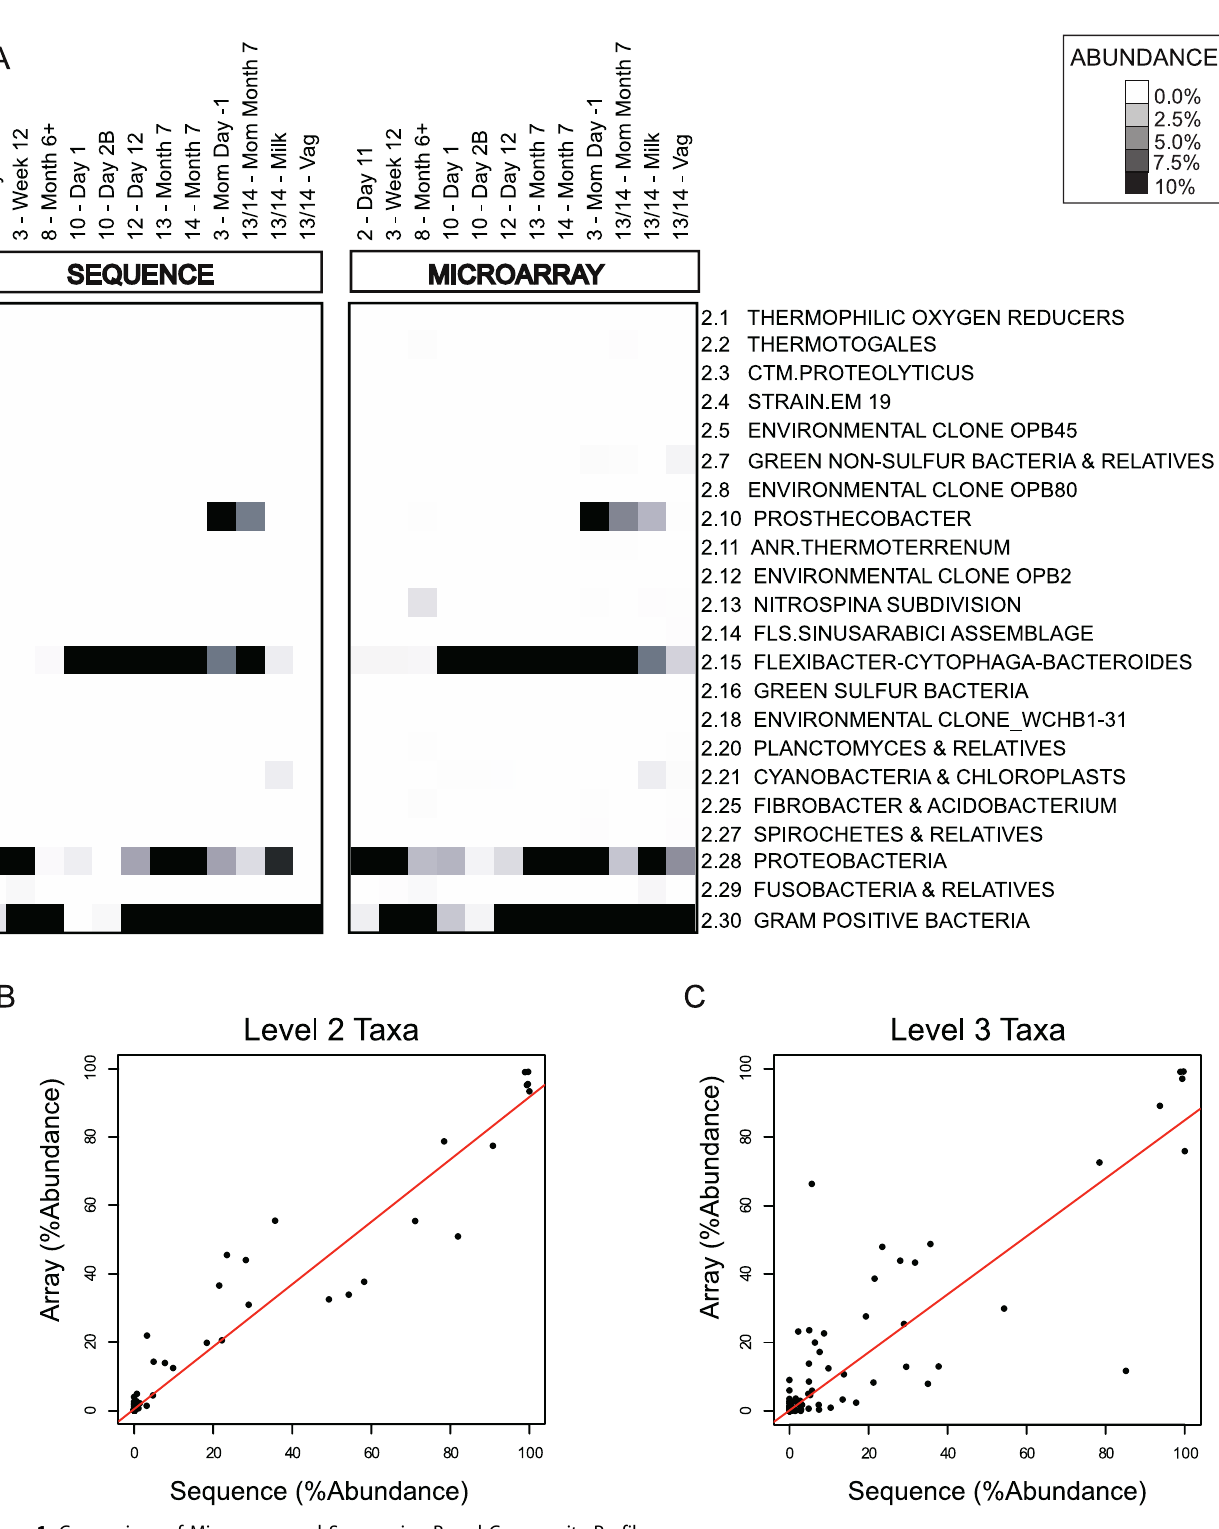
Figure 1. Comparison of Microarray- and Sequencing-Based Community Profiles Microarray-derived and sequencing-derived data estimates of taxonomic group abundance are compared for 12 biological samples. (A) Abundance estimates for all prokMSA level 2 taxa measured on the array are compared. Each column represents a single biological sample and each row corresponds to a single taxonomic group, identified (to the right of each row) by its numerical prokMSA OTU code, along with the roughly corresponding conventional name for the group. (B) Comparison of sequence-based and microarray-based relative abundance estimates for level 2 taxonomic groups in 12 samples (same as in [A]). The x -axis represents the relative abundance as estimated by the frequency of clones from a given taxonomic group, and the y -axis represents the relative abundance as estimated by microarray profiling. (C) Same as (B) for level 3 taxonomic groups. doi:10.1371/journal.pbio.0050177.g001 PLoS Biology |